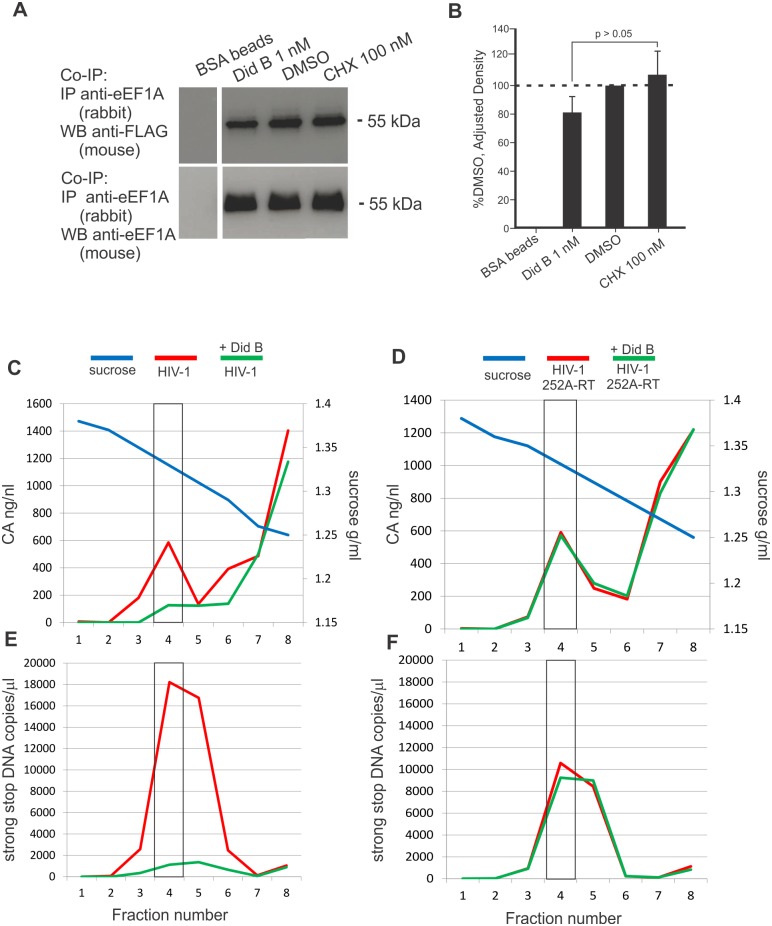
The effect of didemnin B on RT-eEF1A interaction in vitro and viral RTCs in cells.(A) Cell lysates from HEK293T cells transiently expressing HIV RTp51-FLAG were incubated for 30 min at 37°C with concentrations of Did B, CHX or DMSO as indicated. Immunoprecipitation was performed using a rabbit anti-eEF1A antibody and visualized by western blot using anti-FLAG (upper panel) or mouse anti-eEF1A antibodies (lower panel). The experiment was performed three times with similar results. (B) Western blots in (A) were analyzed by densitometry. Normalized density values for RTp51 were calculated by dividing the relative density of RTp51 in each sample lane by the relative density of the eEF1A in the same lane [45]. The columns represent the mean normalized densities and standard deviations of three independent experiments relative to the DMSO treated value. Student’s two-tailed T test was used to calculate statistical significance (C—F) HEK293T cells were treated with Did B at 0.8 nM or with DMSO carrier. The cells were infected with VSV-G psuedotyped wild type (C and E) or W252A RT mutant (D and F) HIV-1. A lysate was prepared and viral RTCs were purified by isopycnography using a 20% to 70% linear sucrose gradient. Fractions collected from the tube bottom were assayed for (C and D, left y-axis) CA by ELISA and (E and F, left y-axis) viral strong stop DNA by qPCR. The density of the sucrose in each fraction (C–F, right y-axis) is indicated by the blue line. The box in each graph indicates a fraction with a density of 1.33 g/ml. The experiment was repeated twice with similar results and a representative outcome is shown.